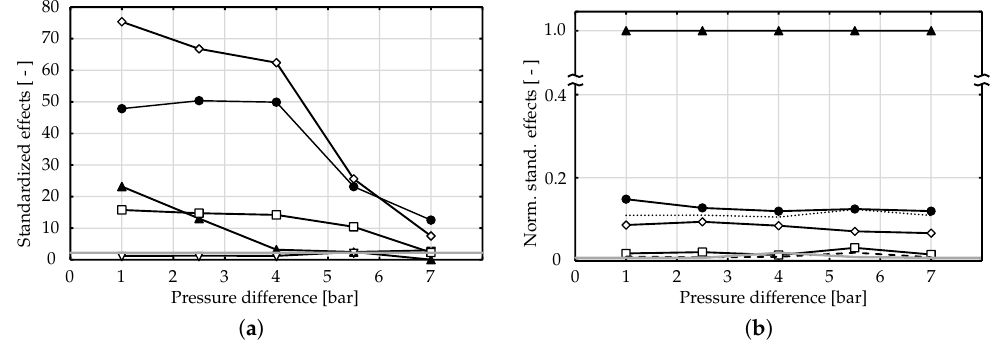
Figure 12. Standardized effects over variation of the pressure difference, significance level α = 0.05, λ Rotor ( Reference line ( ), ( a ): Response variable: Heat flux distribution, ( b ): Response variable: Max. temperature in rubbing contact.